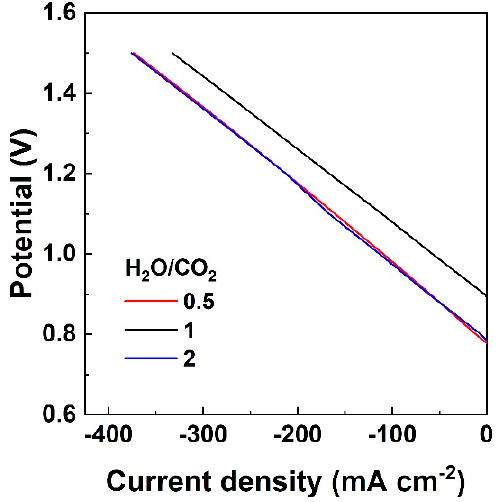
Figure 1. Current density-voltage (iV) curves recorded at 900 ◦ C under electrolysis of CO 2 -H 2 O mixtures, for three S/C ratios of 0.5, 1 and 2, with H 2 in balance with He in the fuel electrode side and pure oxygen in the oxygen electrode side in all cases.